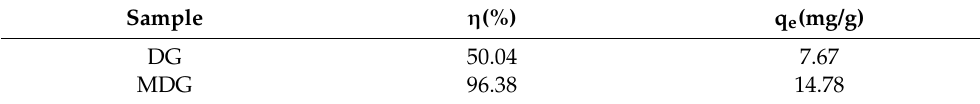
Figure 10. The photograph of ( a ) MG solution, ( b ) DG, and ( c ) MDG adsorption of MG solution. Table 2. The adsorption performance parameters of DG and MDG on MG solution.